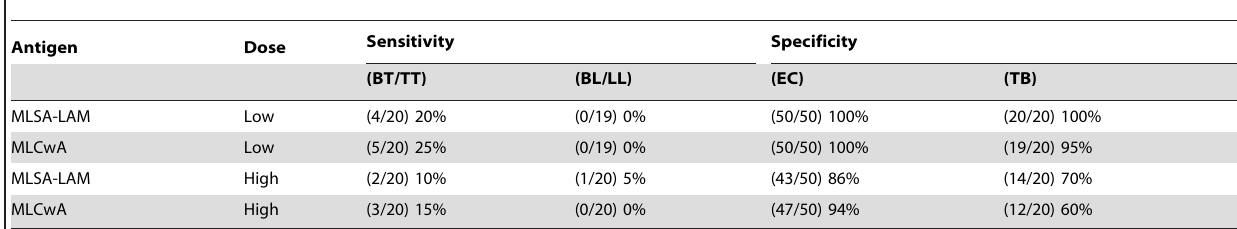
Table 3. Diagnostic test statistics – Skin